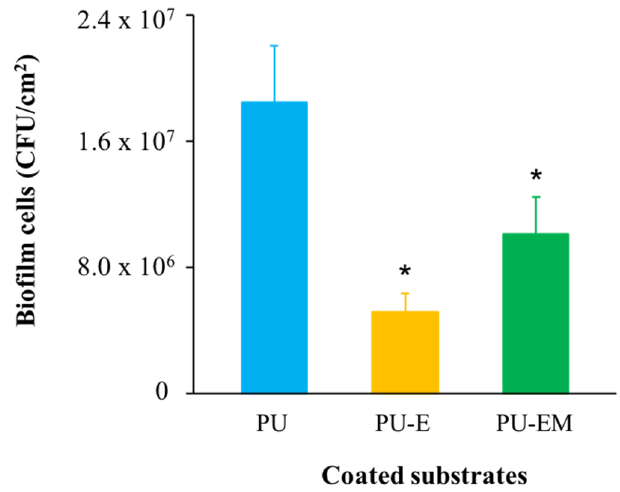
Figure 5. Anti-biofilm performance of pristine polyurethane (PU)-based coating (control), and PU coatings containing incorporated (PU-E) and grafted Econea biocide (PU-EM) against Enterococcus faecalis under dynamic conditions. The means ± standard deviations (SDs) for two independent experiments are presented. Statistical differences ( p < 0.01) are pointed as * when each PU modified coating (PU-E or PU-EM) is different from the control.